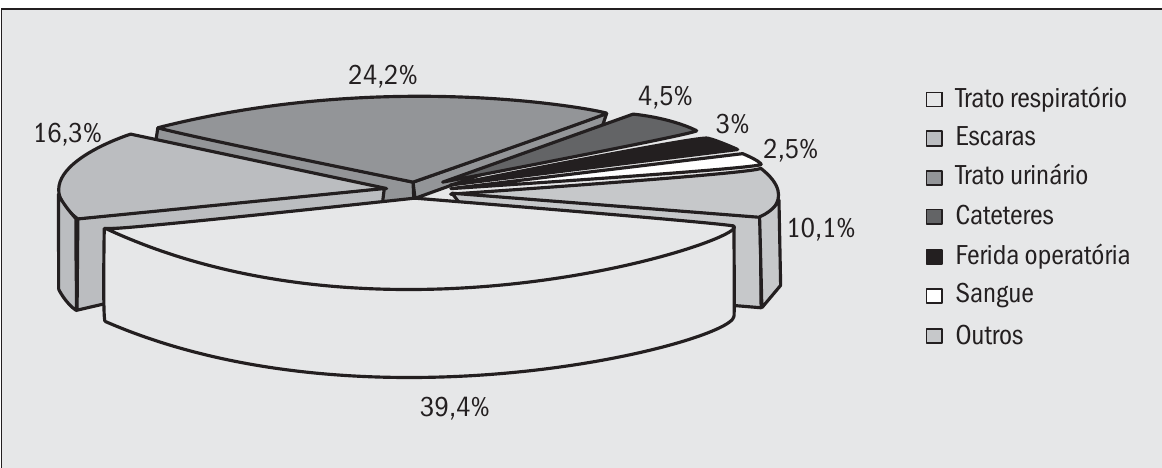
Figura 6 – Locais de isolamento das 198 amostras de P. aeruginosa testadas